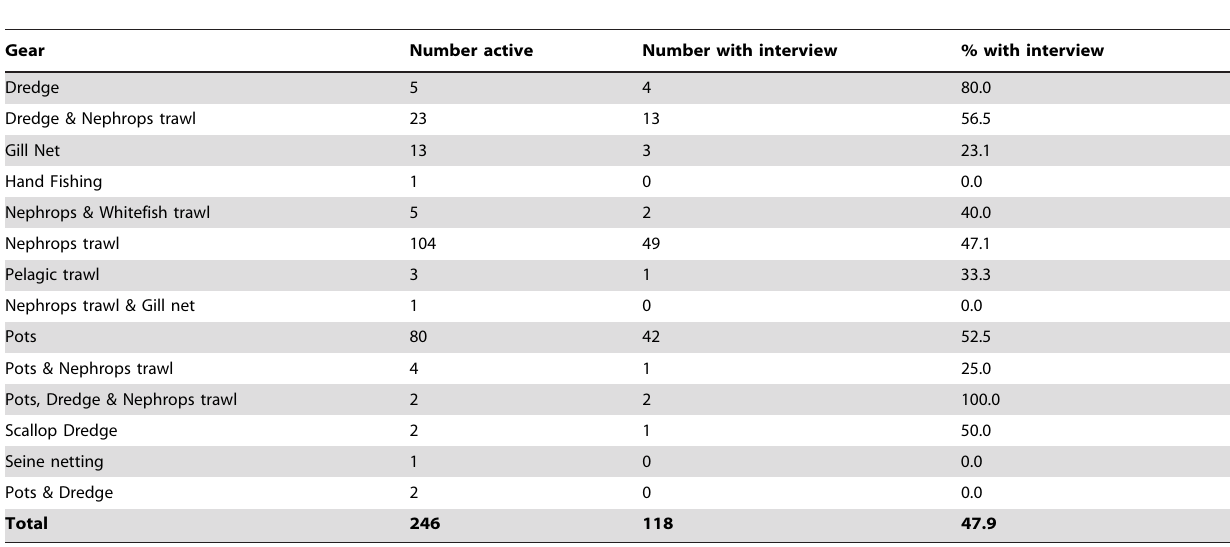
Table 2. Comparision of the number of registered active Northern Ireland fishing vessels and the number with interviews, by gear type.